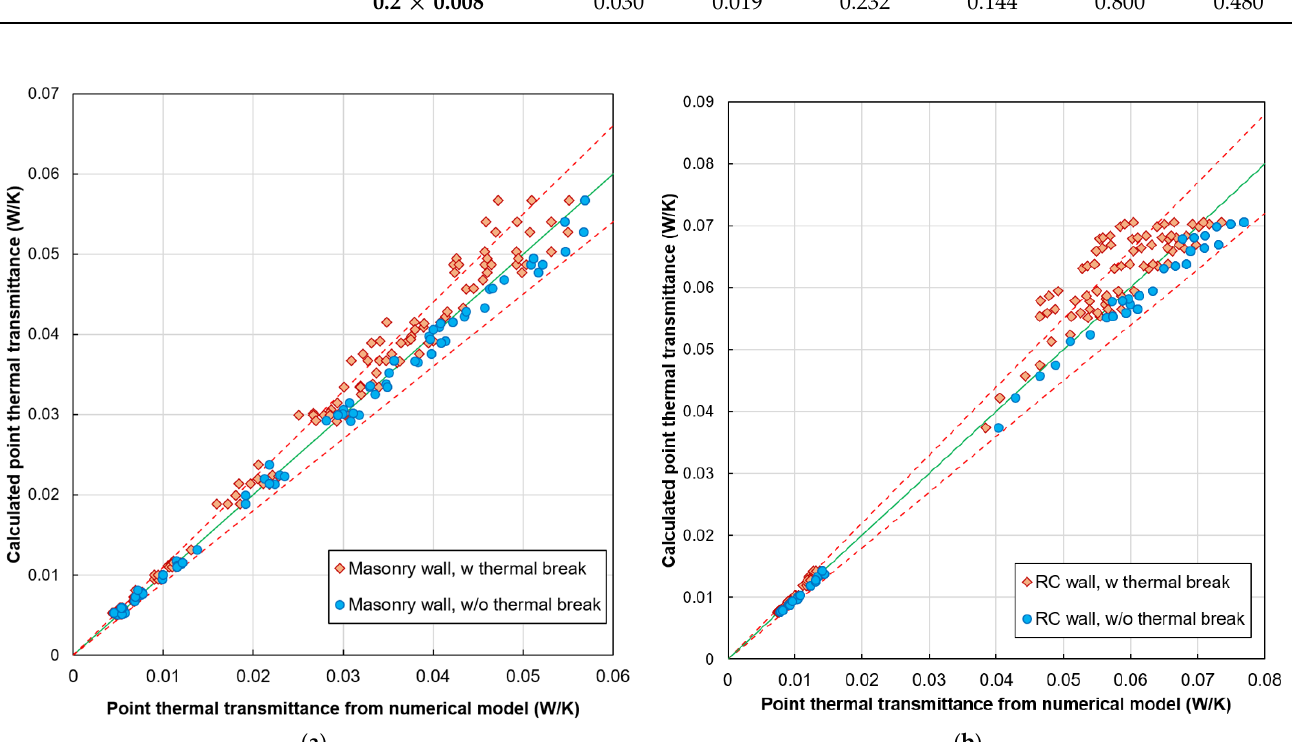
Figure 11. Comparison of calculated and numerical modelled point thermal transmittance in the case of masonry ( a ) or RC ( b )